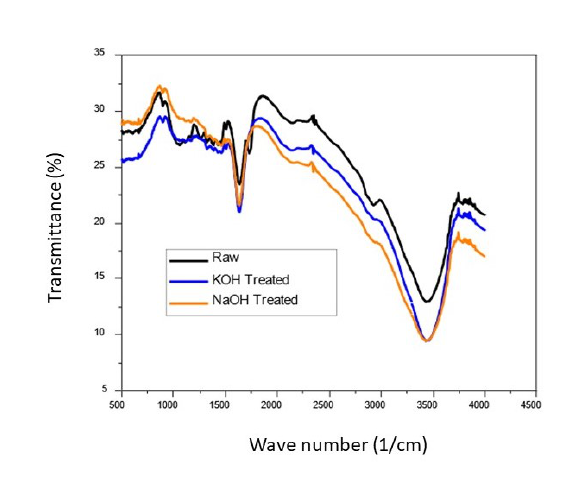
Fig. 4. FTIR of PFs before and after NaOH and KOH